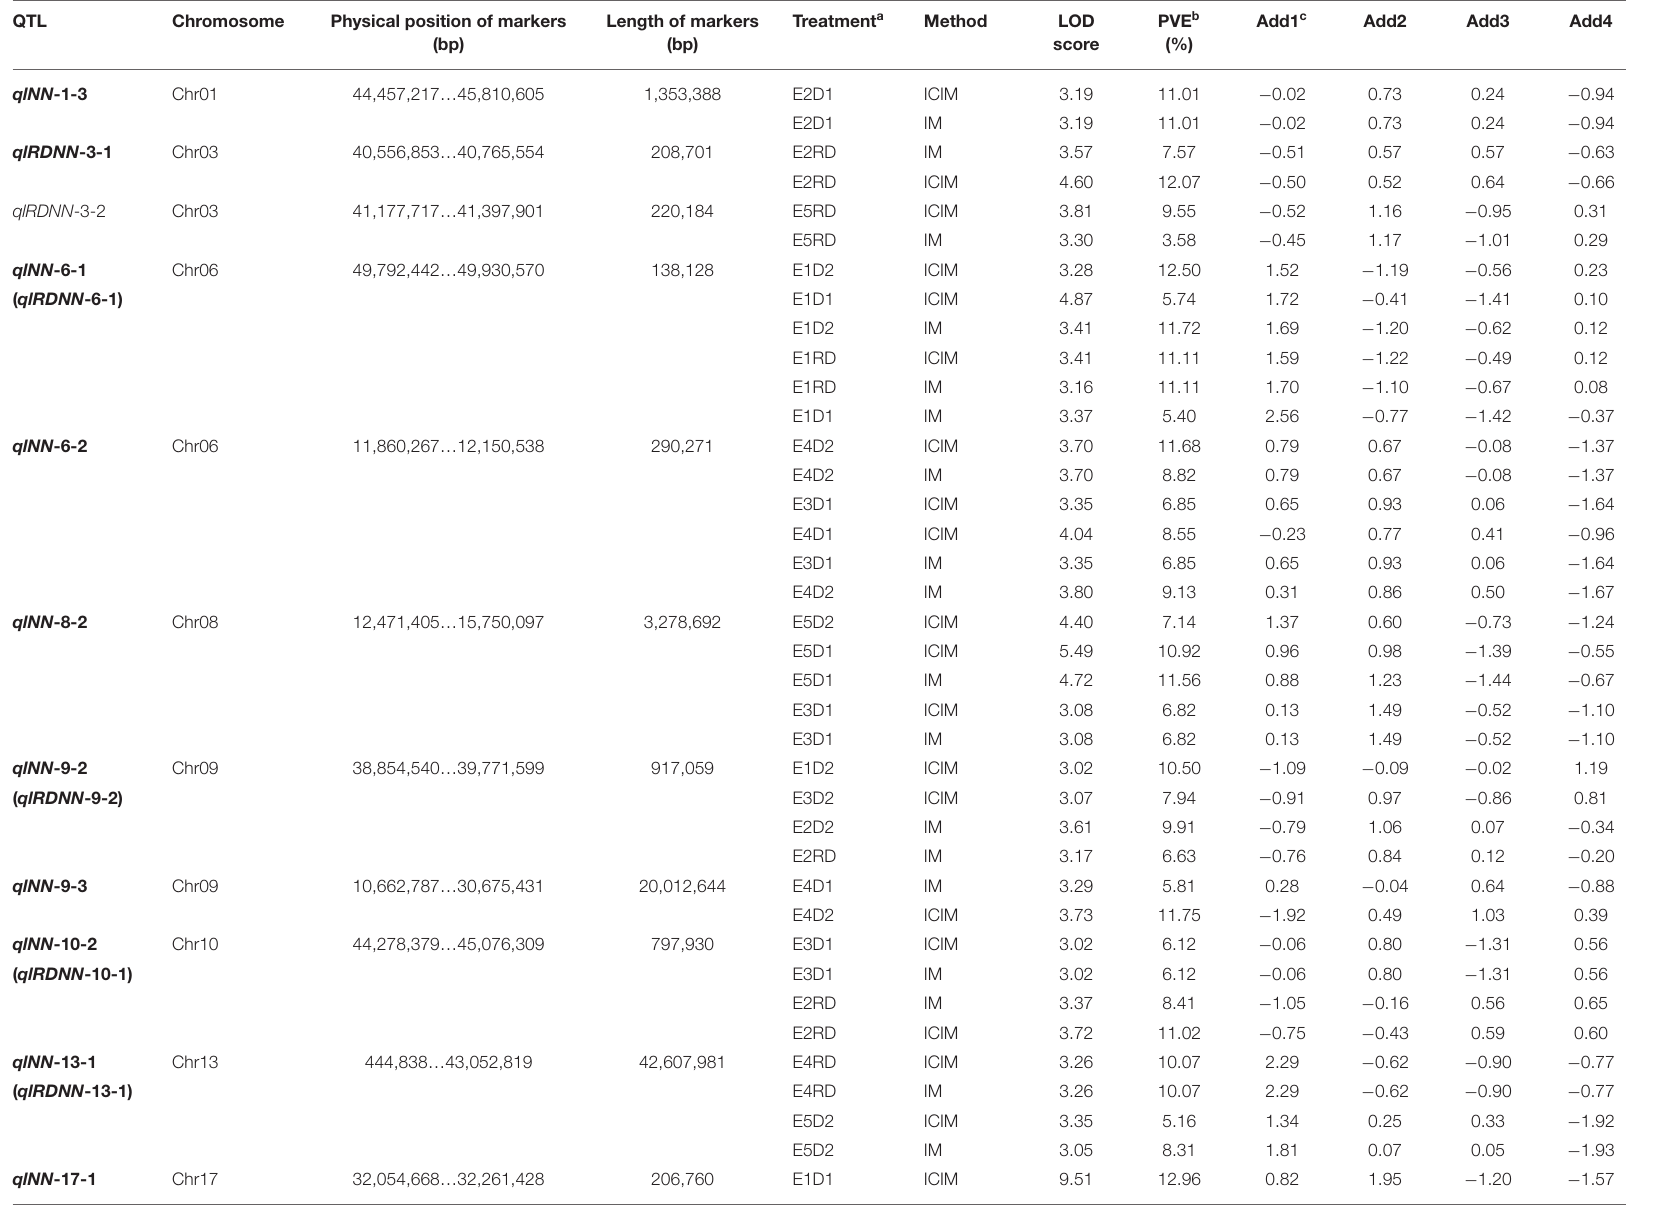
TABLE 3 | Stable quantitative trait loci (QTL) for main stem node number (MSNN) identified under different densities in different environments with different methods. QTL Chromosome Physical position of markers